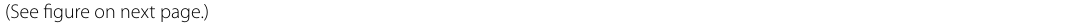
(See figure on next Fig. 6 Major lithologic features of the Voirons Sandstone. a Marl‑dominated section of the Bons Mb. (46.2552° N, 6.3911° E). b Block of the Signal Mb. from the Monastery road exposure with pink granite fragments (black arrows). c Glauconitic sandstone at the La Renardière outcrop (46.2239° N, 6.3679° E) (L6 lithofacies). d Polished section of the red‑algae rich sandstone from the La Moutonnière exposure. e Polished section of cross‑stratified bed from the Bons quarry (L5 lithofacies). f Bentonite layers from the Bons quarry. g Pink granite inclusions in a limestone block beneath the Pralère (46.1973° N, 6.3485° E). h Microphotograph of the limestone with pink granite fragments